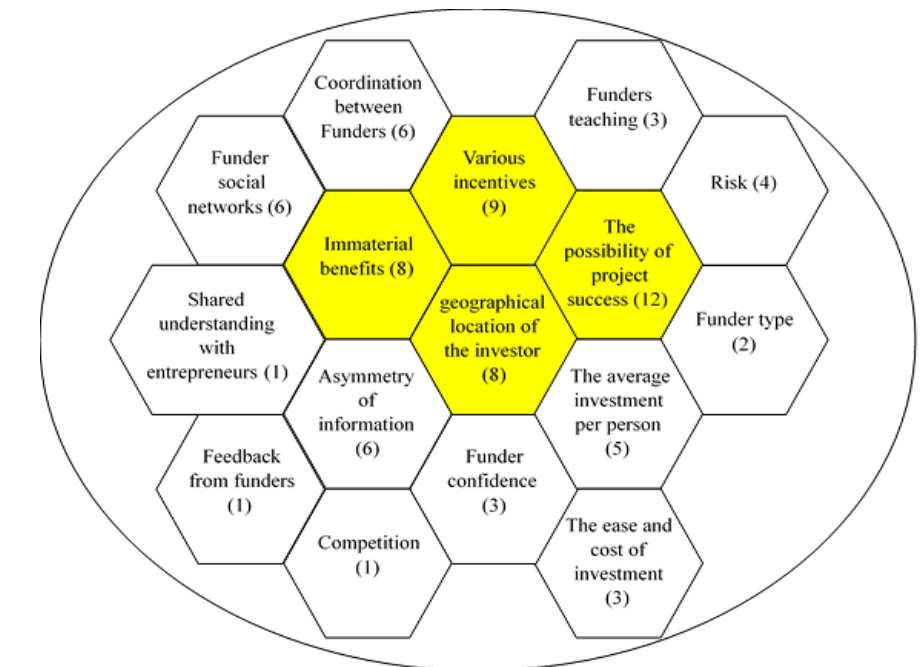
Figure 12. Clustering hexagons associated with